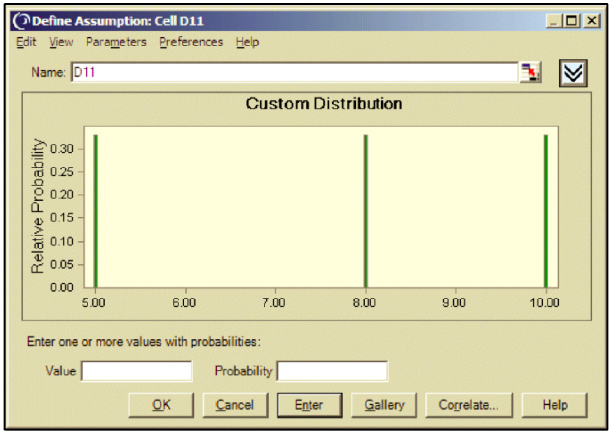
Figure 7. Custom assumptions of CB software for the Monte Carlo simulation.